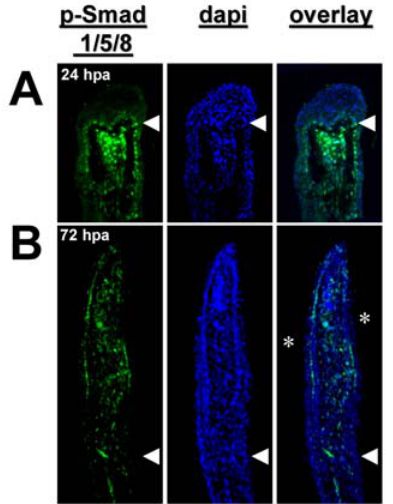
FIGURE 7 . Smad 1/5/8 is phosphorylated in the mesenchyme and in the basal layer of the wound epidermis. (A) 24-hpa Smad 1/5/8 is phosophorylated in the mesenchyme proximal to the amputation plane and in the basal wound epidermis. (B) At 72 hpa, Smad 1/5/8 is still phosphorylated in the wound epidermis, but reduced in the area indicated with asterisks. White arrowheads indicate amputation